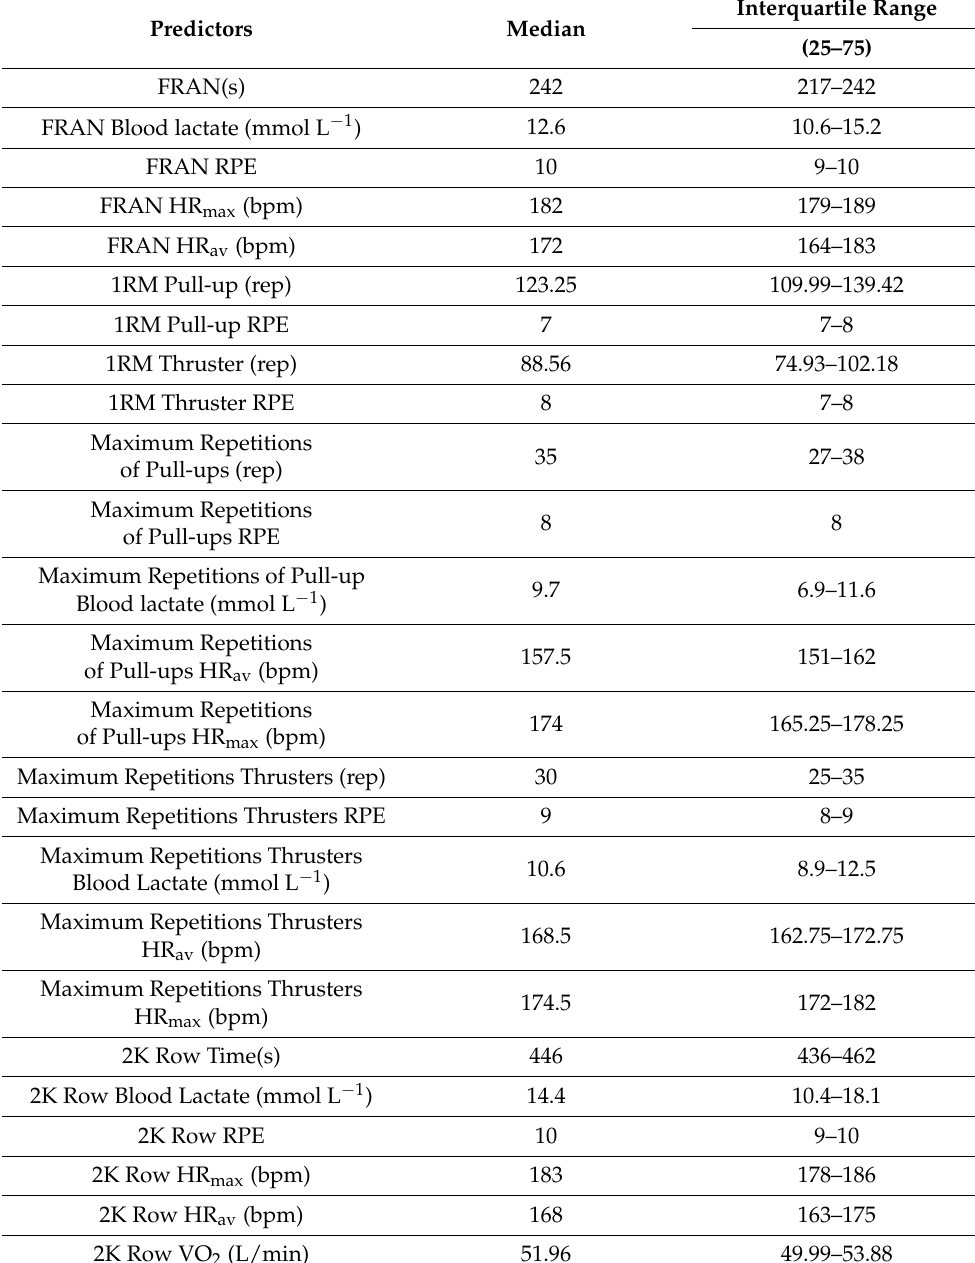
Table 1. Physiological Performance Tests for the Prediction of